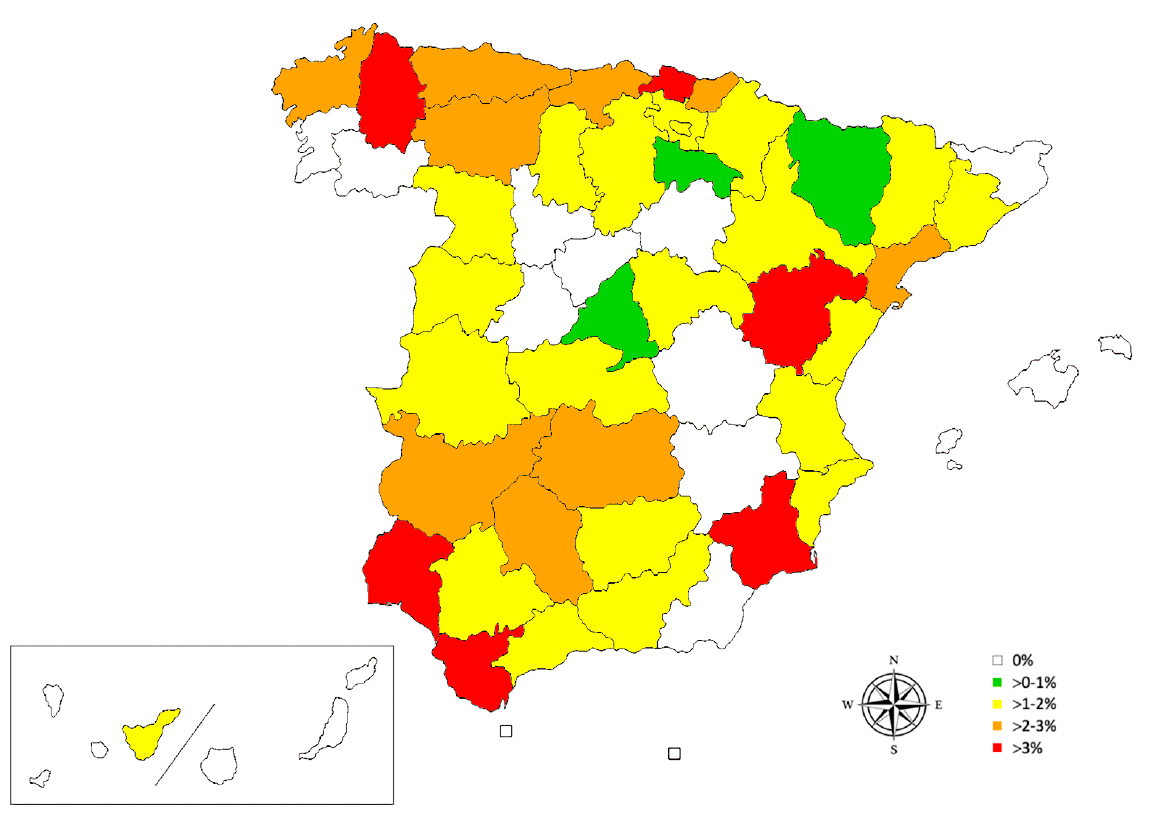
Figure 2. Prevalence map for A. vasorum in domestic dogs in Spain by province and the autonomous cities of Ceuta and Melilla.